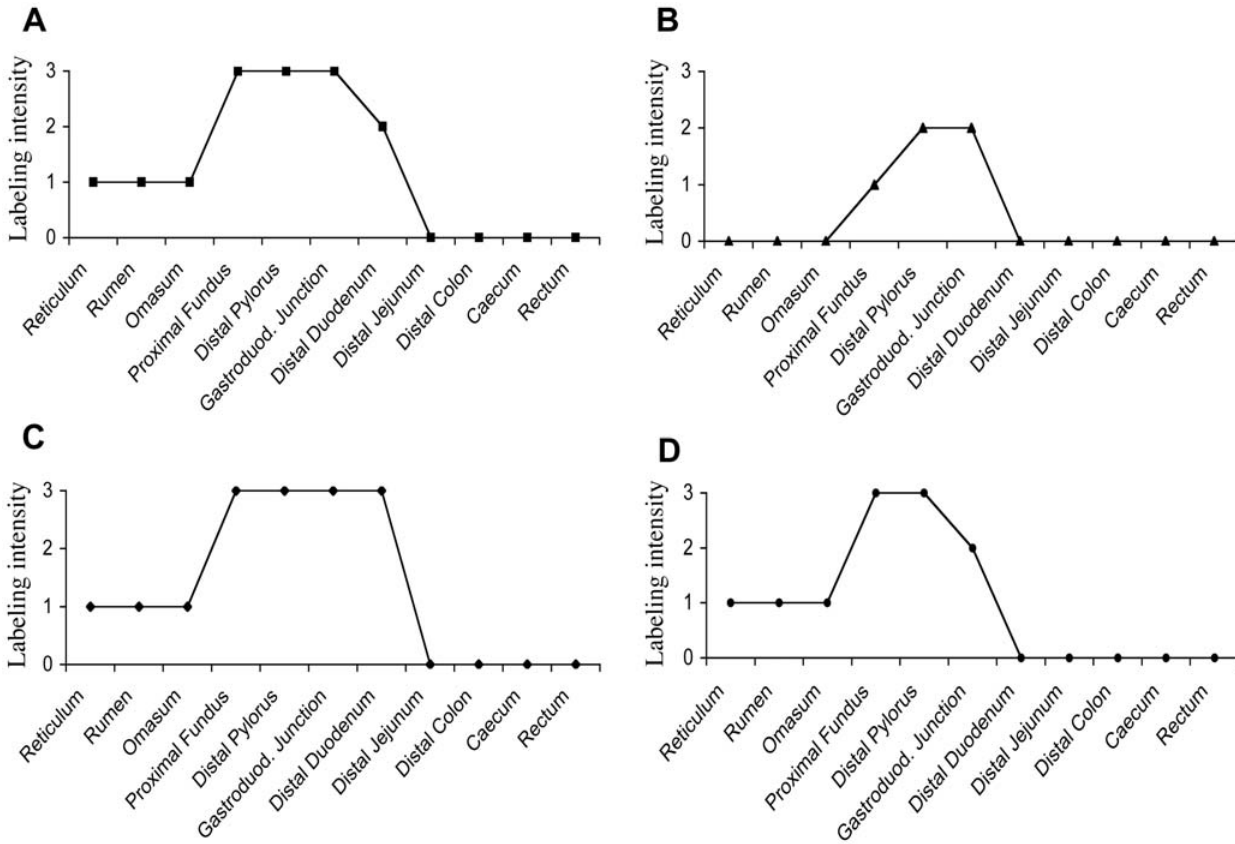
Figure 2. Expression of rNB2 VLPs ligands and of HBGAs along the bovine digestive tract. Expression of rNB2 VLPs epithelial ligands and HBGAs on the various parts of the digestive tract was determined by immunohistochemistry (see Fig. 1). Intensity of labeling shown on the y axis was visually graded from strongly positive (grade 3), moderately positive (grade 2) to weakly positive (grade 1) and negative (grade 0). (A) NB2 VLPs ligands ; (B) a Gal epitope detected using either the GS1-B4 isolectin or the 4F102c2 mAb ; (C) A blood group antigen detected using mAb 9113D10 which recognizes all types of A epitopes ; (D) Htype2/Le y epitopes detected using either the UEA-I lectin, or the 19-0LE mAb. *In addition to epithelial cells, rNB2 VLPs, GS1-B4 and the 4F102c2 mAb stained the vascular endothelium throughout the digestive